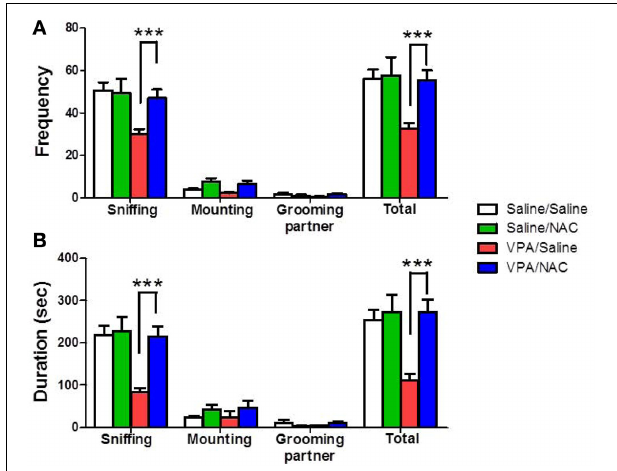
FIGURE 2 | Reversal of the social interaction deficit in VPA-exposed offspring by NAC. Rats of VPA- or saline-expose offspring weaned at postnatal day 21 (P21) were used in this experiment. NAC (150mg/kg, i.p.) or saline was administered once per day for 10 days (P21 to P30). On P28, the male offspring were tested for social interaction. The duration (A) and the frequency (B) of occurrence of various social behaviors such as sniffing, mounting and grooming partner were measured in the VPA- and saline-exposed offspring for 20min. Sample sizes ( n ): Saline/Saline n = 21, Saline/NAC n = 5, VPA/Saline n = 25, VPA/NAC n = 17. ∗∗∗ p < 0 . 001 vs.